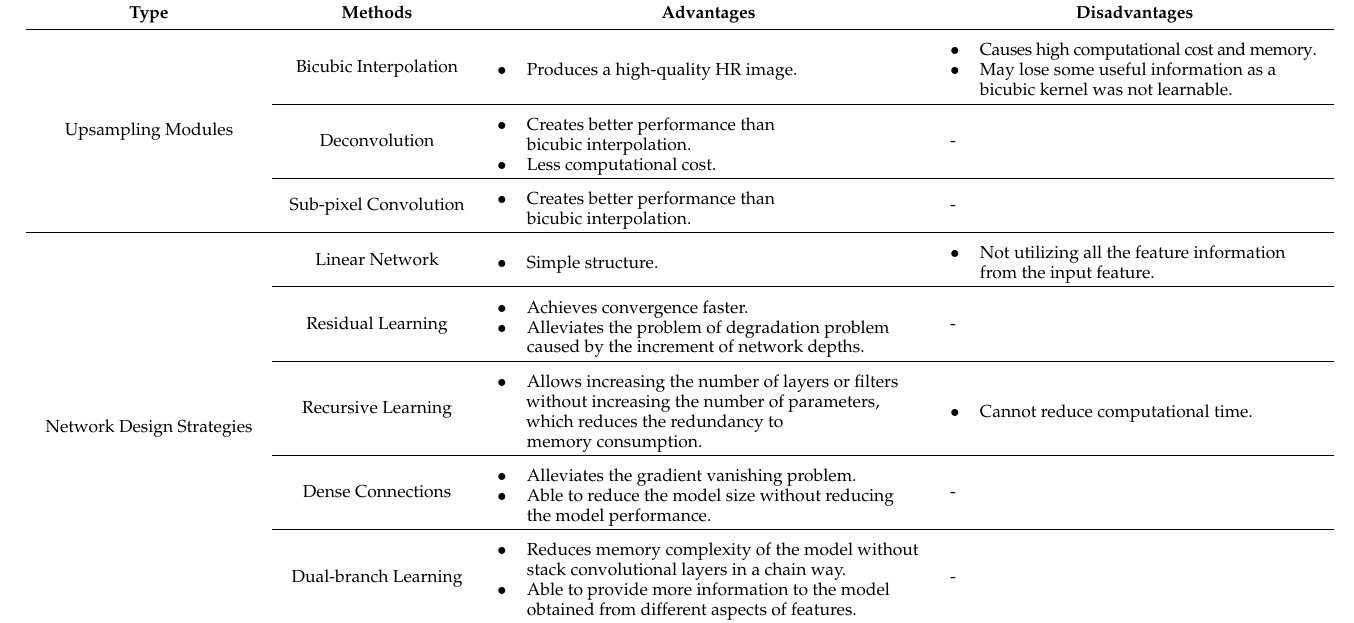
Table 7. Advantages and disadvantage of each upsampling modules and network design